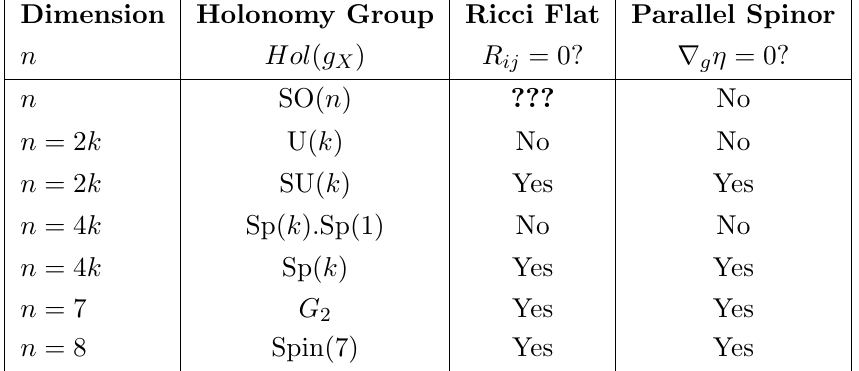
Table 1 . Riemannian Holonomy Groups, Ricci Flatness and Parallel